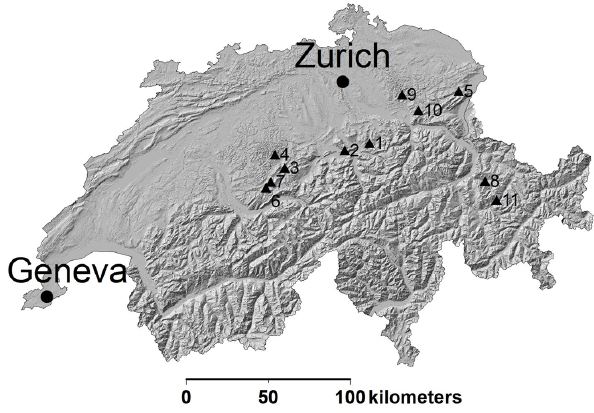
Figure 1. Location map of the Erlenbach (1) and the ten streams studied by Rickli and Bucher (2006) in Switzerland (see also Ta- ble